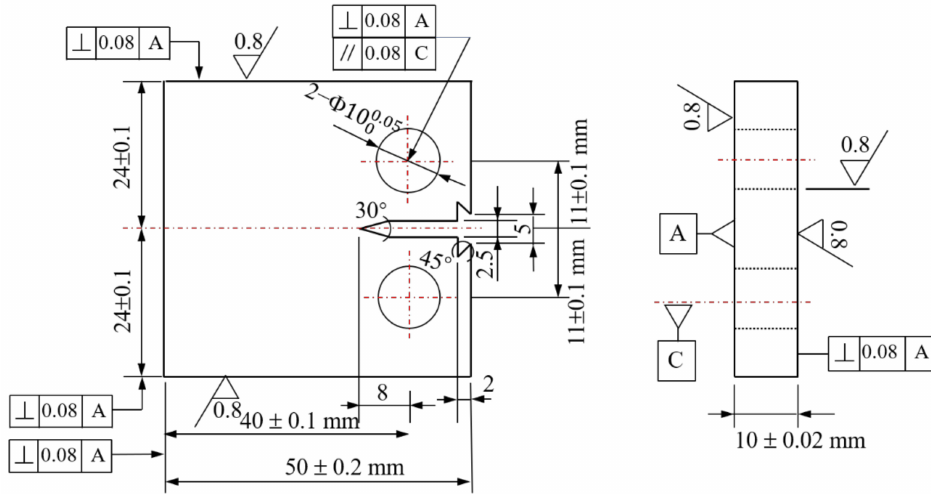
Figure 3. Specification of fatigue crack propagation